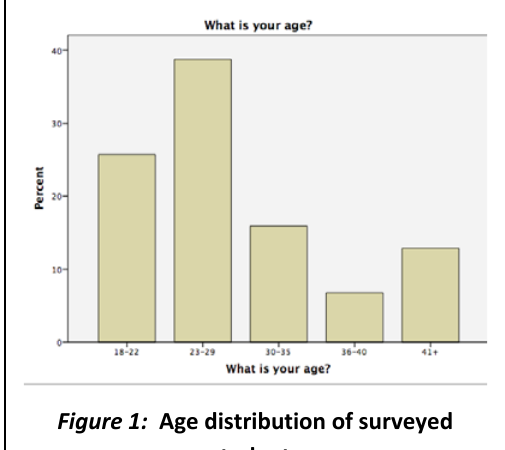
Figure 2: Type of school distribution